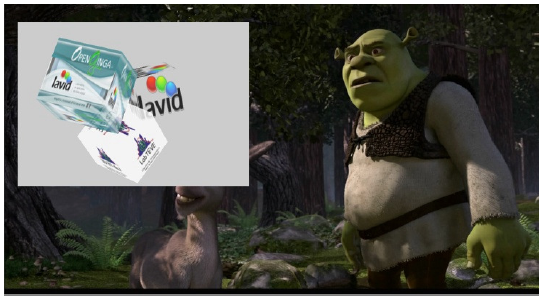
Figure 8. JSR 239 application running on middleware Ginga.